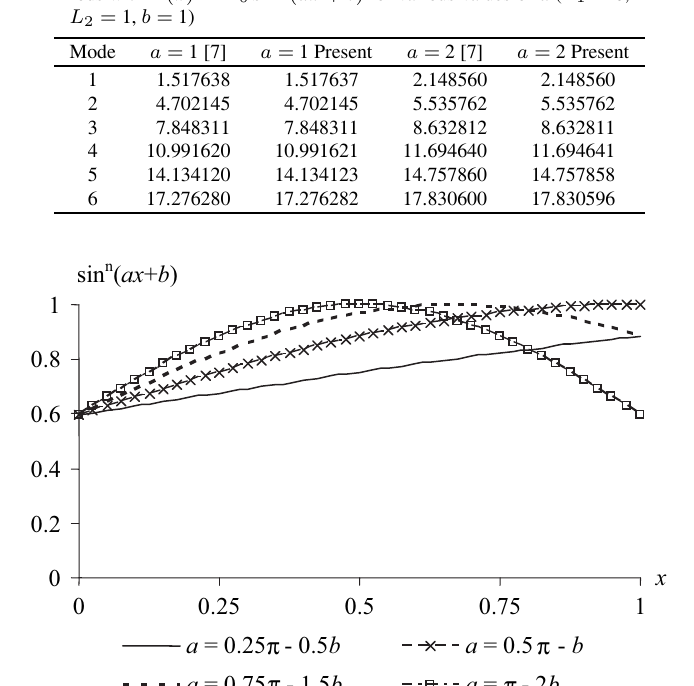
Table 1 Comparison of non-dimensional natural frequencies of clamped-free